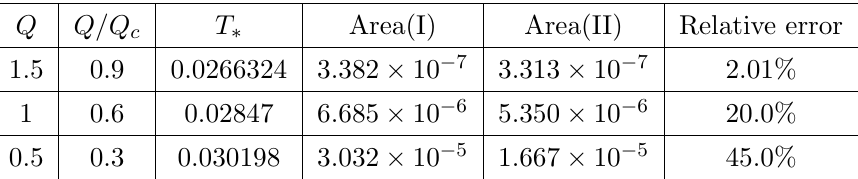
Table 2 . The failure of the equal area law for the two-point correlation function. Similarly as